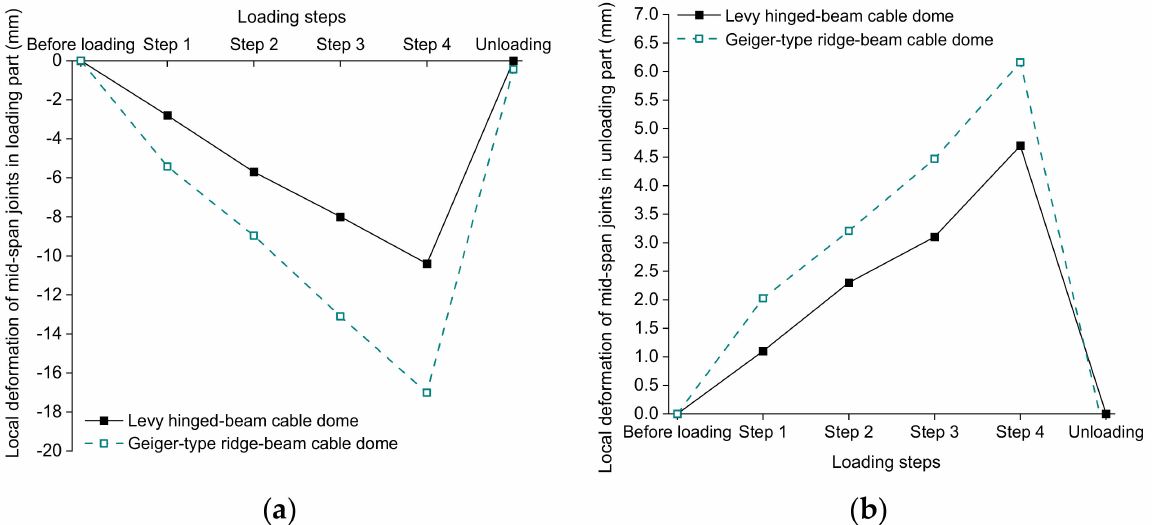
Figure 32. Comparative results of the local deformation on the mid-span joints of the HBs. ( a ) Loading part; ( b ) Unload- ing part.